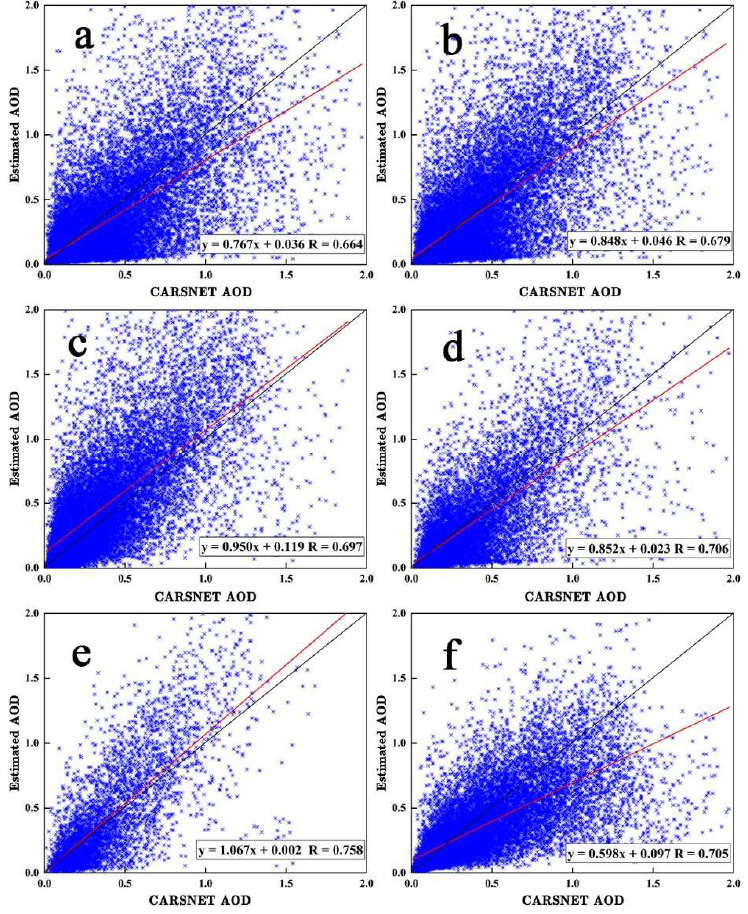
Figure 8. Validation of AOD products from MODIS and MERRA2during 2002–2014: ( a ) MODIS08DB; ( b ) MODIS08DTBC; ( c ) MODIS08MEAN; ( d ) MODIS04DB; ( e ) MODIS04DT; and ( f ) MERRA2.